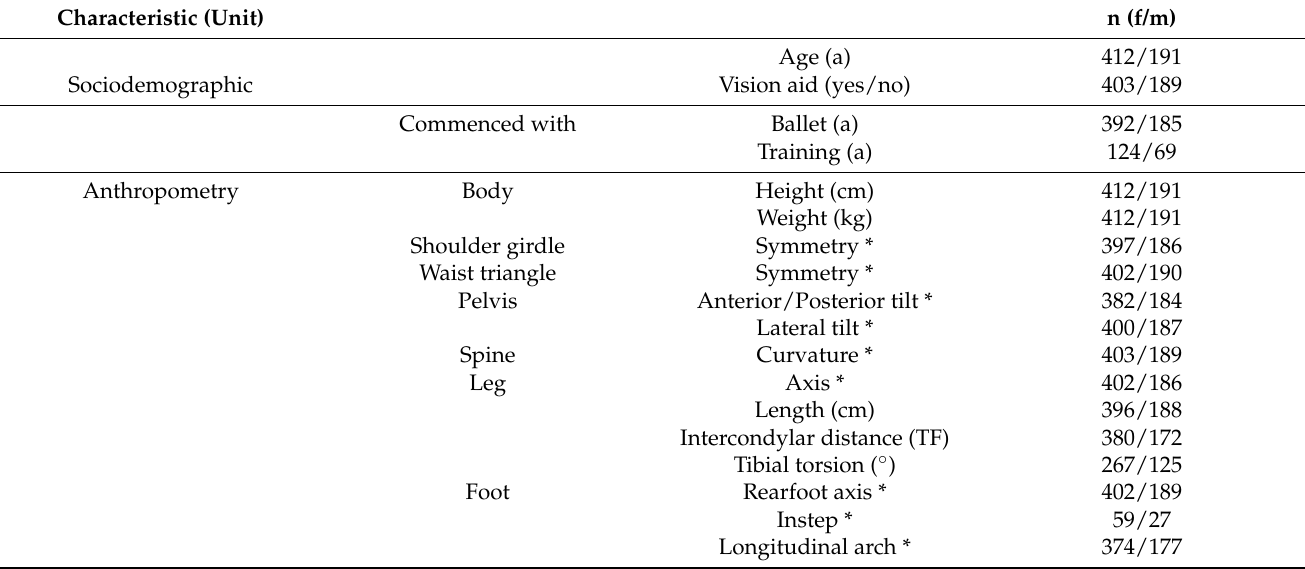
Table 1. Surveyed Characteristics with respective